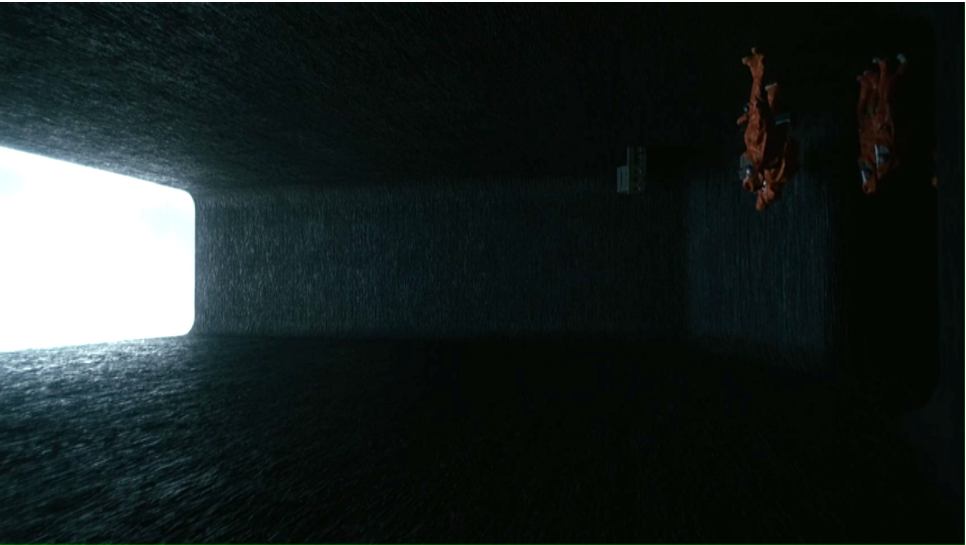
Figure 5: Arrival . A cosmic pilgrimage.